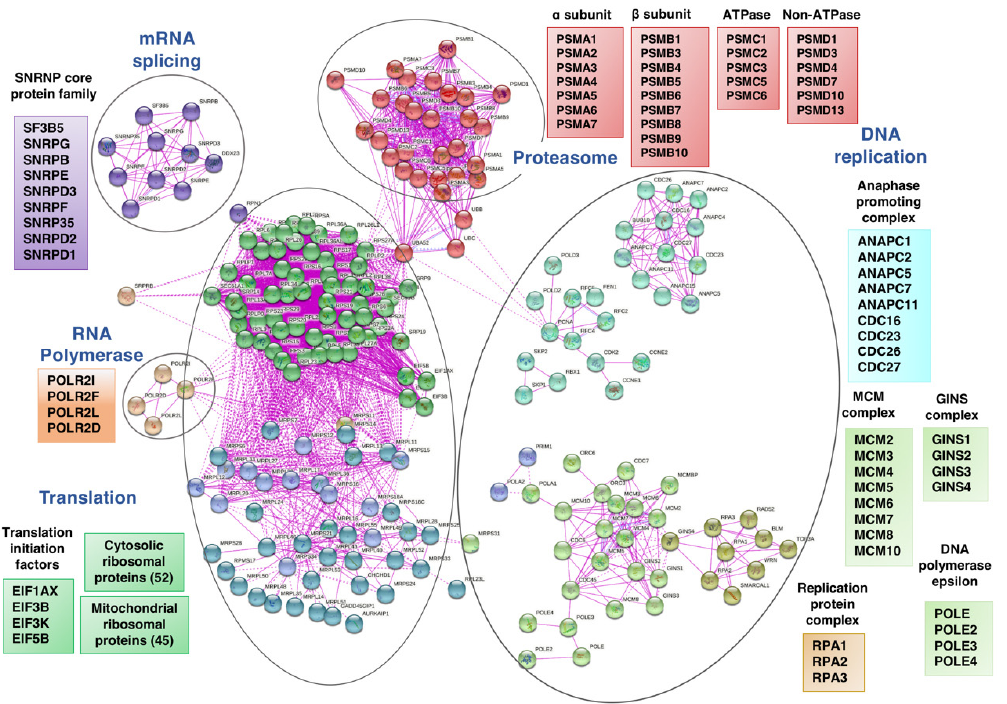
Figure 5. Network analysis of selected REACTOME categories of proteins corresponding to downregulated genes in HepG2 cells treated with Sorafenib (10 µM, 12 h). The analysis was undertaken using the STRING-db protein-protein interaction database (htps:/string-db.org; last accessed 3 February 2022), that relies on experimentally derived structural evidence and an interaction score ≥ 0.7 (highly confident entries) was used.